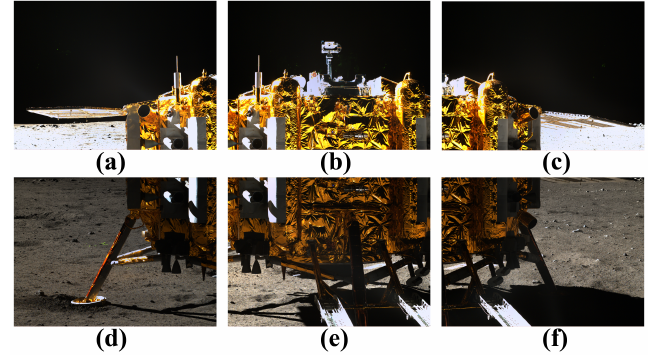
Figure 8. Original images recorded at Point A. ( a ) upper-left image; ( b ) upper-middle image; ( c ) upper-right image; ( d ) lower-left image; ( e ) lower-middle image; ( f ) lower-right image.